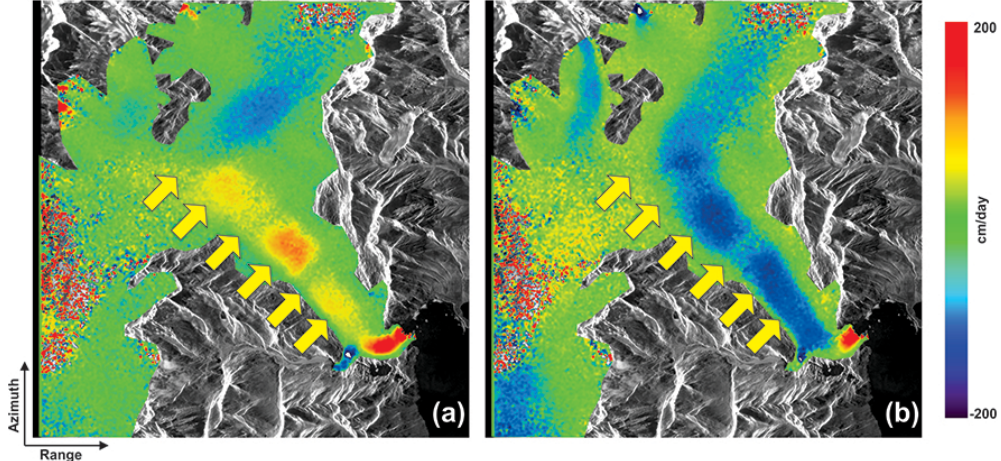
Fig. 3. Offset field in range direction (a) and azimuth direction (b) computed from ascending COSMO-SkyMed SAR images of 15 June 2012 and 16 June 2012.